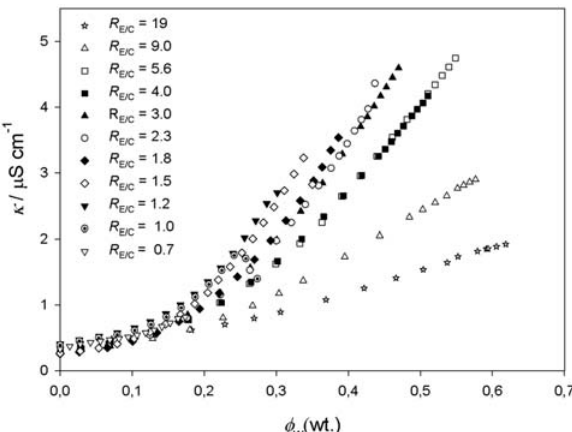
Figure 2. Conductivity κ of the microemulsion as a function of φ at different R values. E/C